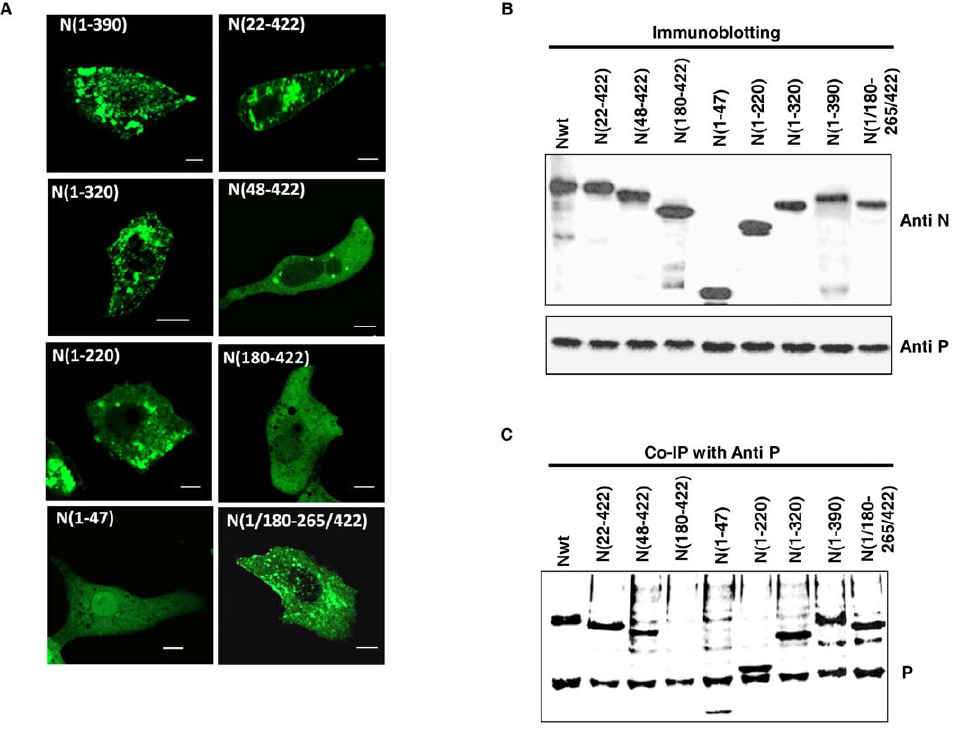
Figure 6. Exvivo expression and immunoprecipitation of different N mutants with P. (A) Intra-cellular distribution of different mutants of N used in this study. Vero-76 cells were transfected with 2 m g of pEGFP-C1 constructs of each mutant. N-terminal deletants N(48–422) and N(180–422) exhibits smooth distribution. N(1–47) also exhibits smooth distribution, probably because of the large GFP-tag, which interferes with its oligomerization. The bar represents 5 m m. (B) Co-expression of wild-type N and different N mutants with P protein in Vero-76 cells. Co-expression was confirmed by immunobloting with N and P Abs (upper and lower panels, respectively). All of the mutants used for this study expresses satisfactorily, and is of the right relative size. (C) Co-immunoprecipitation of wild-type N and different N mutants with P protein. Vero-76 cells were co-transfected with 2 m g of both plasmids, labelled with L-Methionine- 35 S 24 hours post-transfection followed by immunoprecipitation with P Ab. Except for N(180– 422), all mutants co-immunoprecipitate with P.